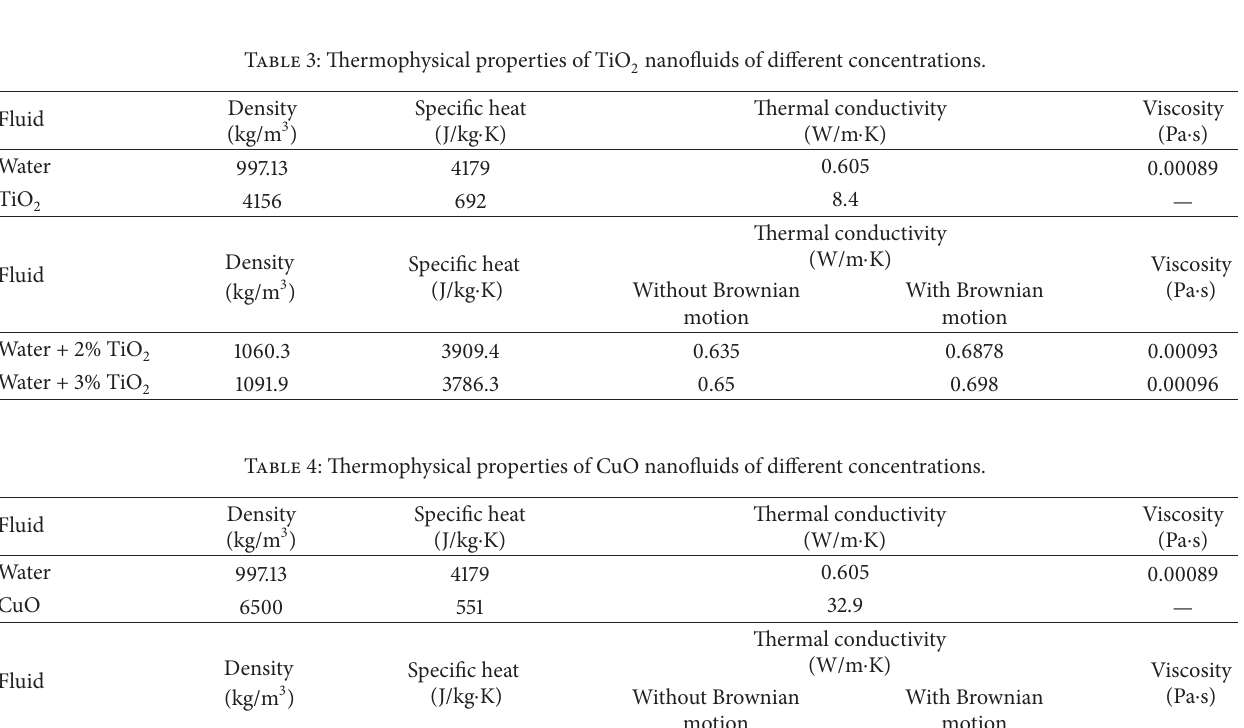
Table 3: Thermophysical properties of TiO